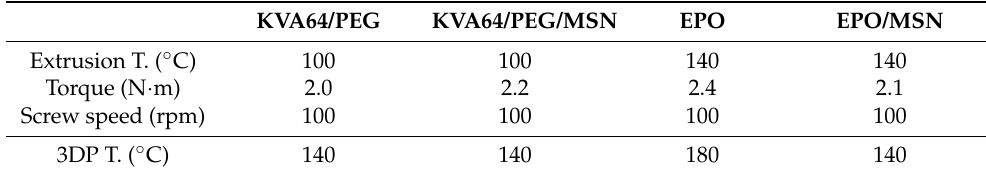
Table 2. Twin-screw tabletop HME parameters for the production of selected polymer